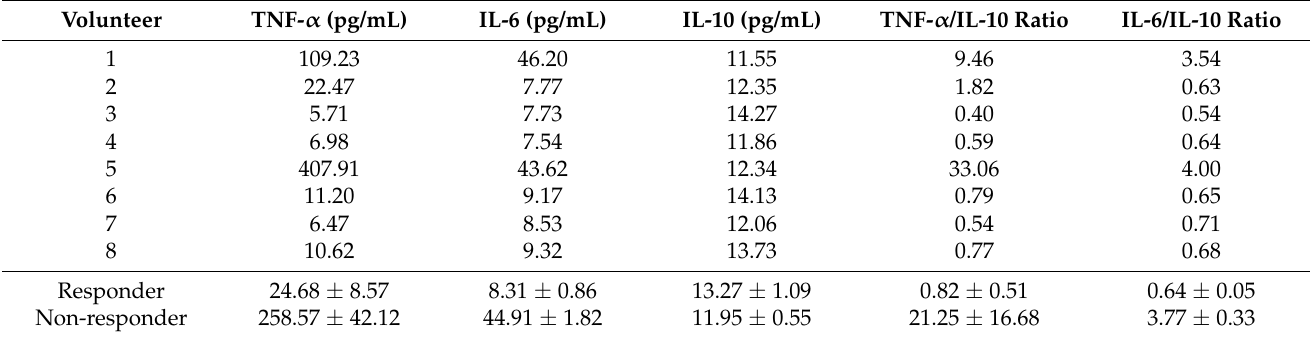
Table 2. Systemic cytokine levels (pg/mL) and the ratio between pro-inflammatory (TNF- α and IL-6) and anti-inflammatory (IL-10) cytokines in the volunteers enrolled in the present study from before the vaccination for COVID-19, both individually and separated into groups of responders and non-responders to the